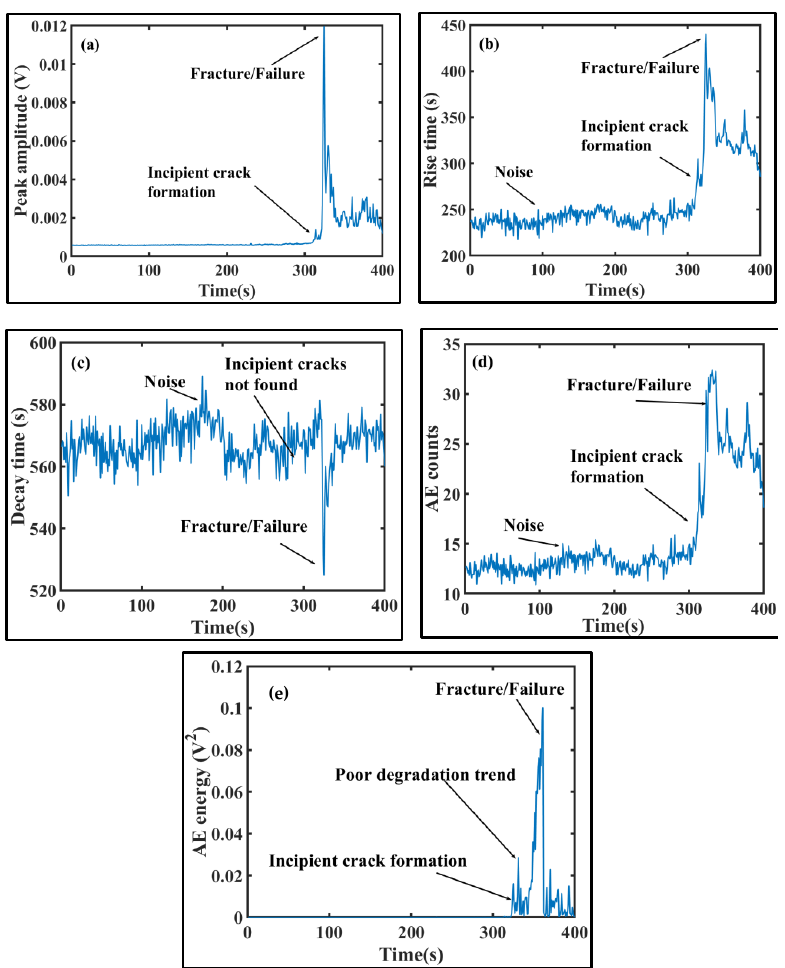
Figure 8. Time history of acoustic emission burst AEB features over the entire life of concrete beam: ( a ) peak amplitude, ( b ) rise time ( c ) decay time, ( d ) AE counts, and ( e ) AE energy.